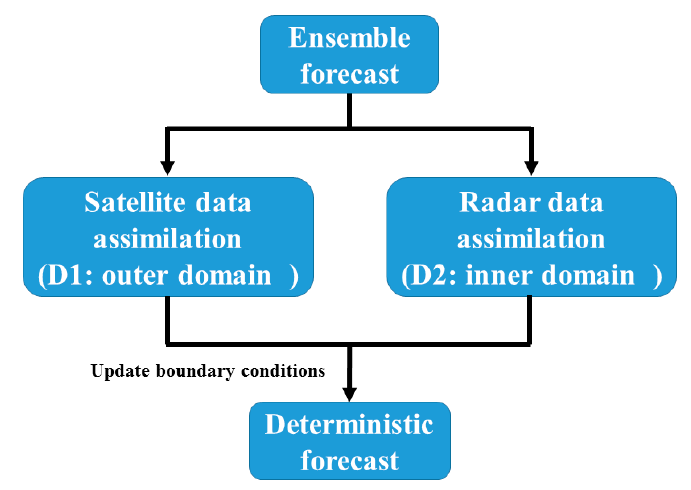
Figure 1. The components of the Proper Orthogonal Decomposition-based ensemble four-dimensional variational (POD-4DenVar) system. See text for details.